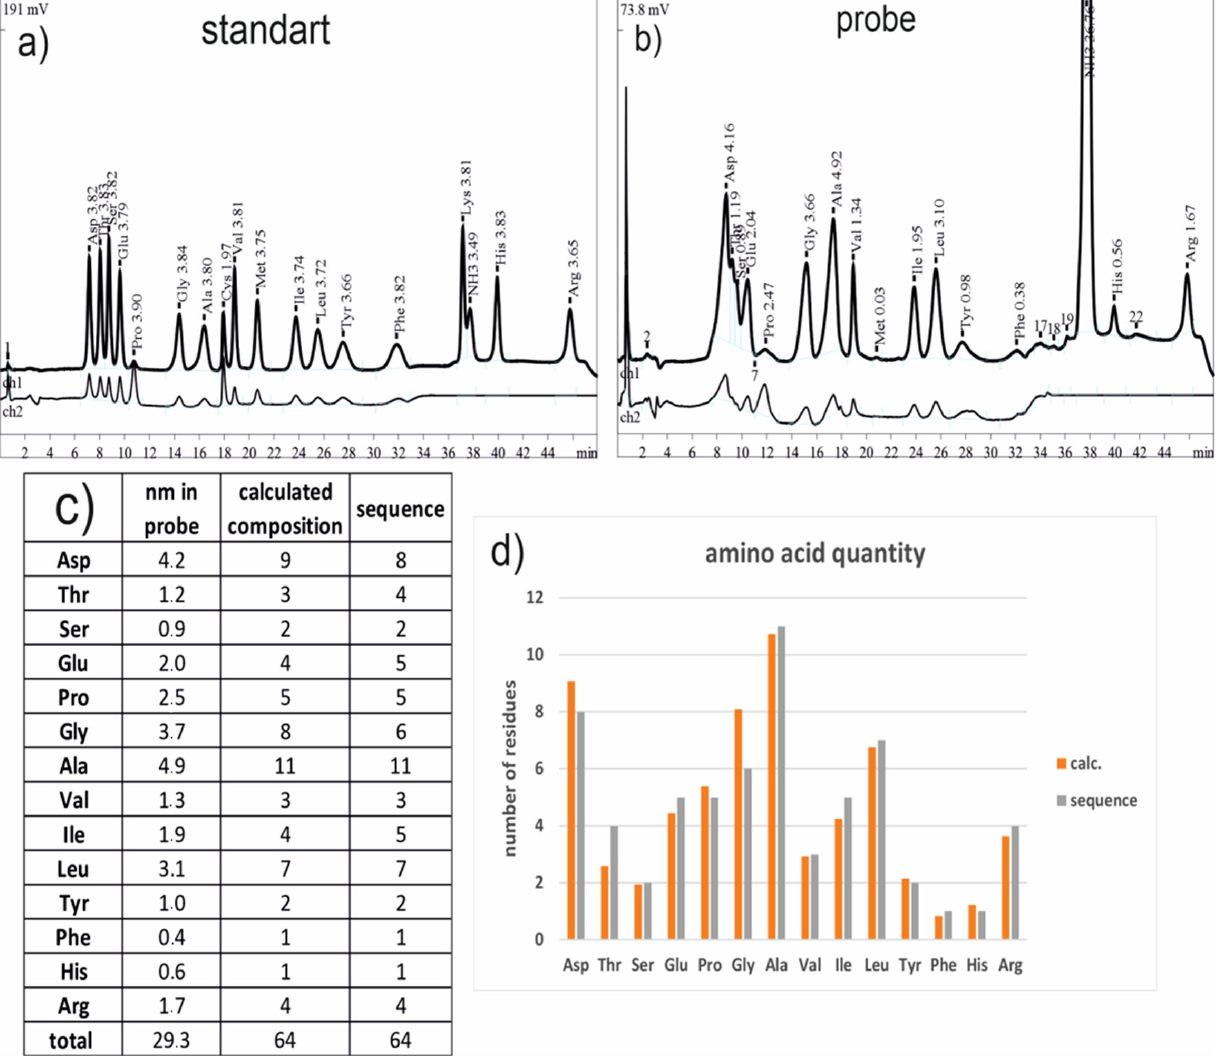
Figure 4. The results of the amino acids’ analysis. ( a ) Chromatogram of the standard mixture of amino acids examined at two wavelengths: 440 nm (ch1) and 590 nm (ch2). ( b ) Chromatogram of the real amino acid mixture, obtained via the hydrolysis of the hydrophobin with mineral acids (ch1 and ch2 are the same as those in ( a )). ( c ) A table with the amino acids’ quantification and transformation into numbers of amino acids in a hypothetical protein in a sample (calculated composition), and the amino acid numbers in a query annotated sequence (sequence). Some of the amino acids are not presented in the table (Lys, Met, Trp, and Cys) due to their degradation; still, the mineral acid hydrolysis take place, and the others (Gln and Asn), at the same conditions, transform into Glu and Asp, correspondingly. ( d ) Information about the amino acid distribution in the protein examined via amino acid analysis (orange bars) and the residue numbers in the annotated sequence (grey) is graphically presented.